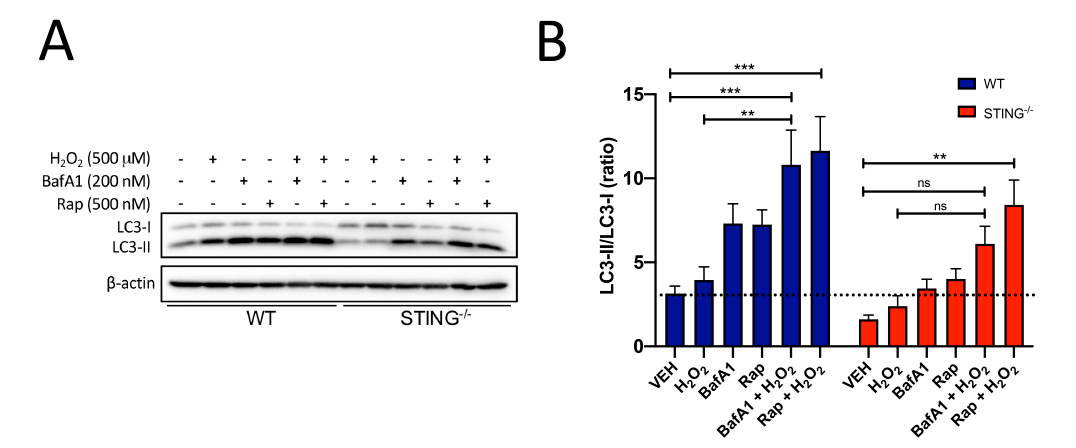
Figure 7. Presence of STING increases autophagy flux in response to H 2 O 2 treatment. WT and STING − / − cells were treated with 500 µ M H 2 O 2 alone or in the presence of 200 nM bafilomycin or 500 nM rapamycin for 3 h. ( A ) Western blot analysis was performed with an LC3 antibody with β -actin as a loading control (representative blot of n = 6 blots). ( B ) LC3-II and LC3-I levels were normalized to β -actin levels; an LC3-II / LC3-I ratio was then determined from these values. Data are expressed as mean ± SEM, **p < 0.01, ***p < 0.0001.